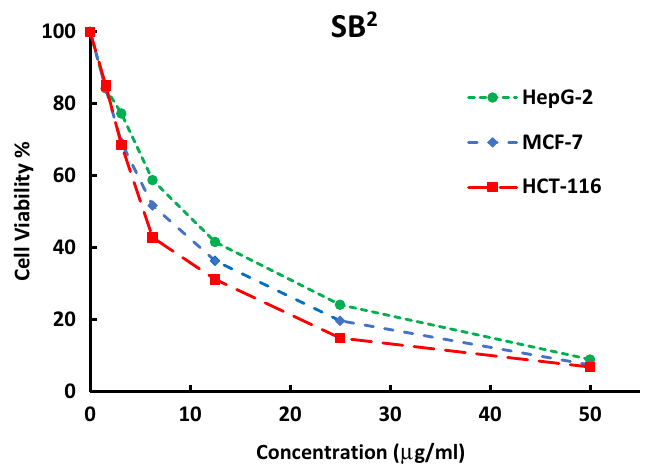
Figure 19. The inhibitory dose curves of SB 2 against three cell lines HepG-2, MCF-7, and